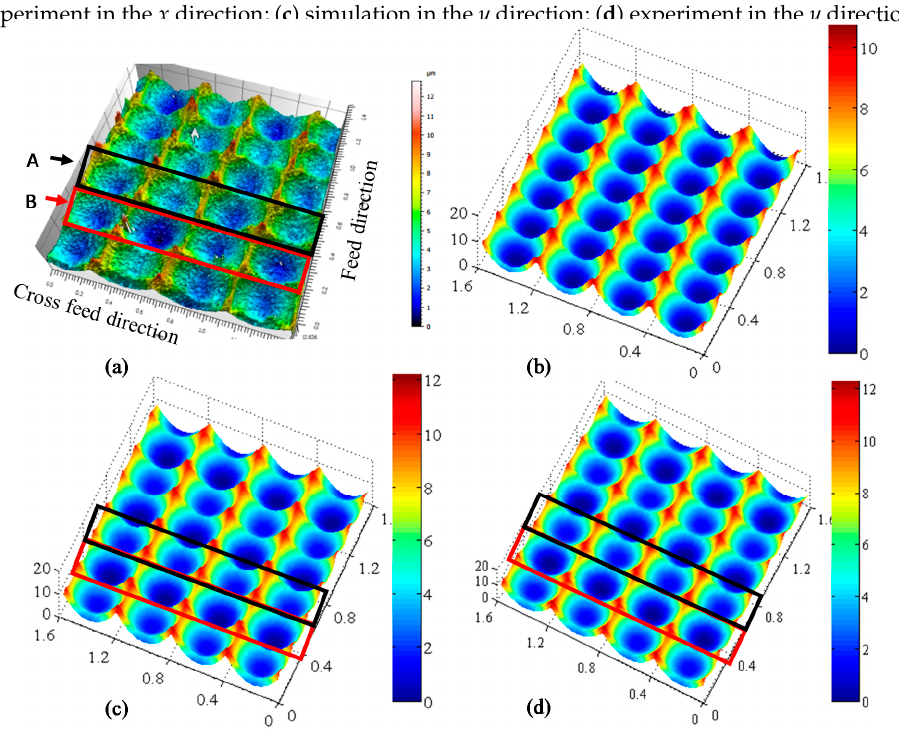
Figure 12. Surface morphology ( a ) experiment (Ra = 0.273 um); ( b ) without cutting vibration (Ra = 0.221 um); ( c ) without impact vibration (Ra = 0.240 um); ( d ) with cutting vibration (Ra = 0.247 um)